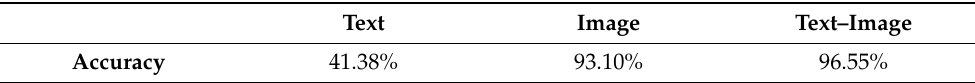
Table 5. Results of classification of all users’